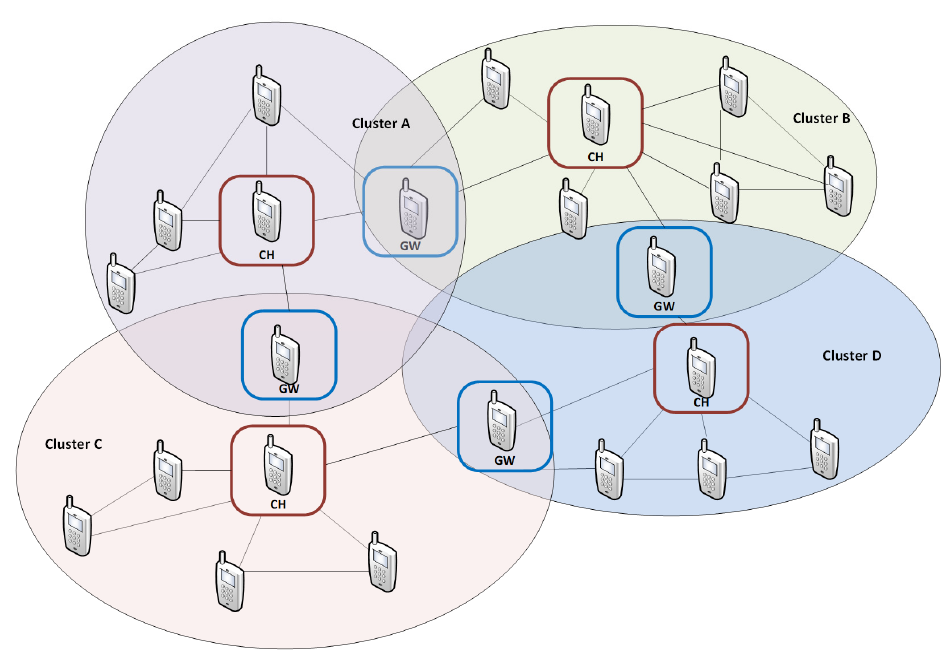
Figure 2. Cluster network example.